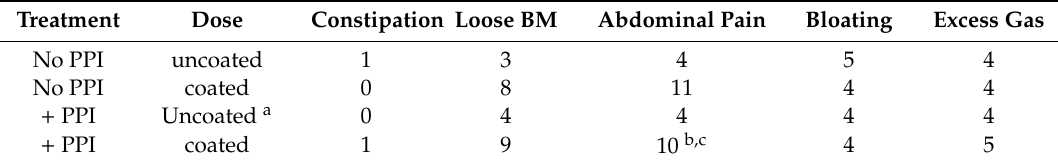
Table 2. Adverse events reported (PPI Phase).